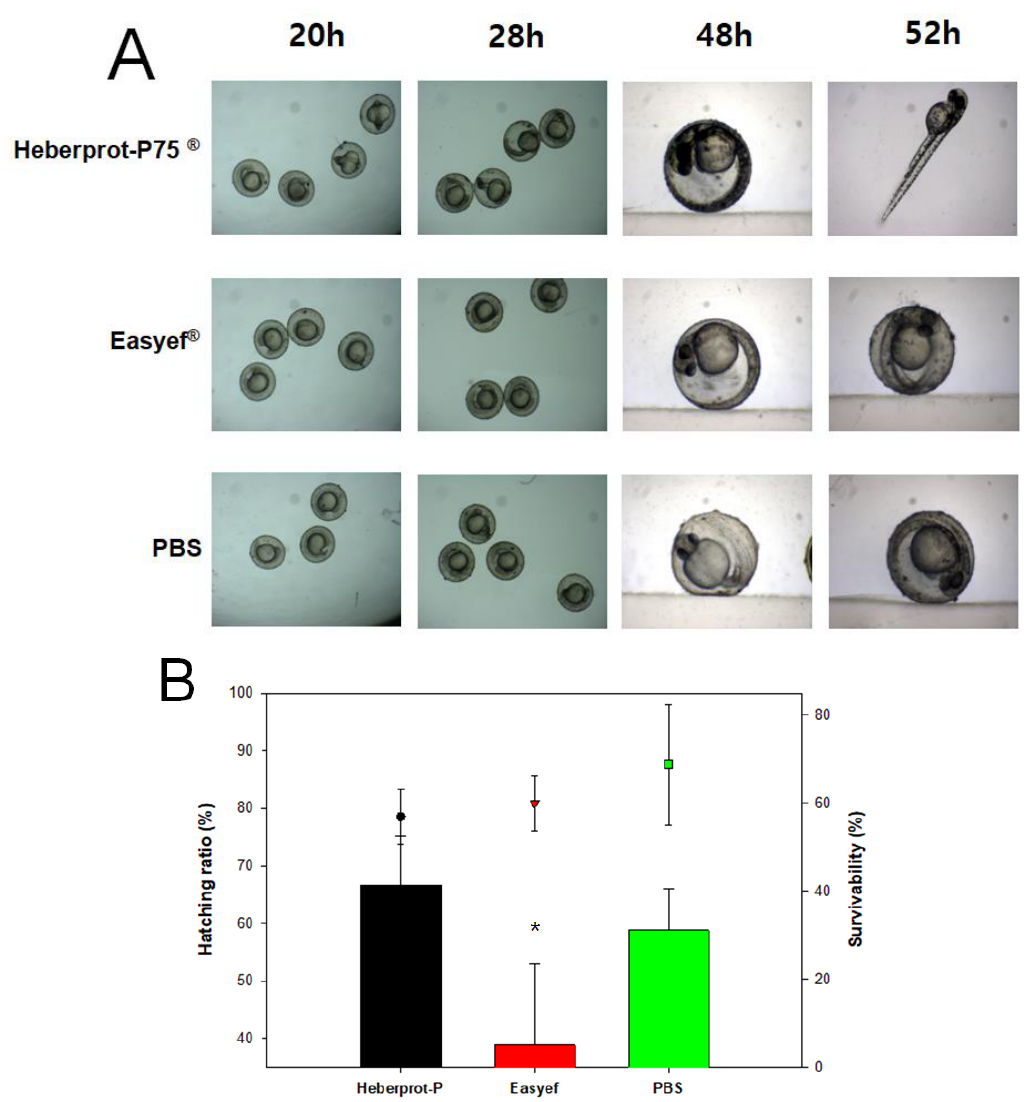
Figure 4. Comparison of developmental speed and morphology after microinjection of Heberprot-P75 ® , Easyef ® , and PBS. ( A ) Photographs show stereo image of the embryo from each group at 20, 28, 48, and 52 h post-injection to compare the developmental stage. ( B ) The graph shows the hatching ratio and survivability at two days post-exposure. *, p < 0.05 versus Heberprot-P75 ®